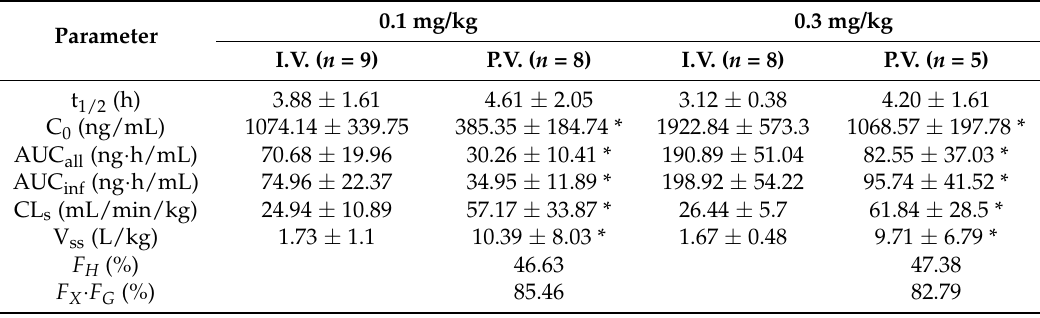
Table 1. Noncompartmental pharmacokinetic parameters of fimasartan obtained after the intravenous (I.V.) and portal vein (P.V.) injections of fimasartan in rats (mean ±